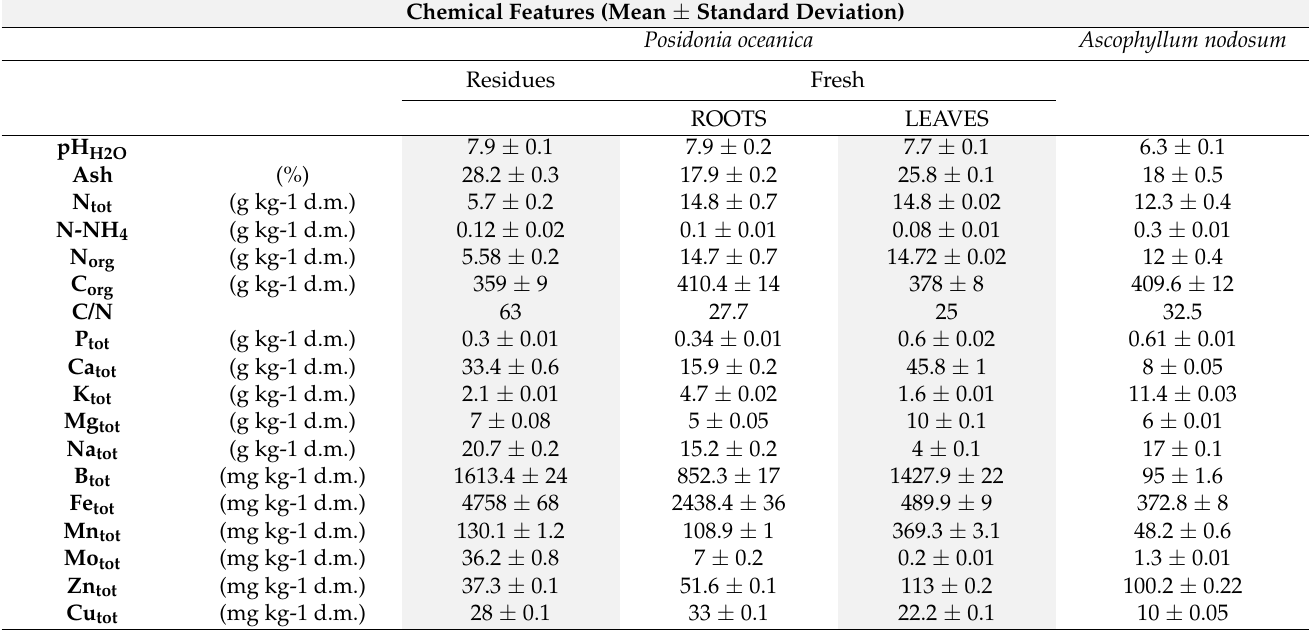
Table 2. Chemical compositions of residues and fresh plants (divided into leaves and roots) of Posidonia oceanica and Ascophyllum nodosum